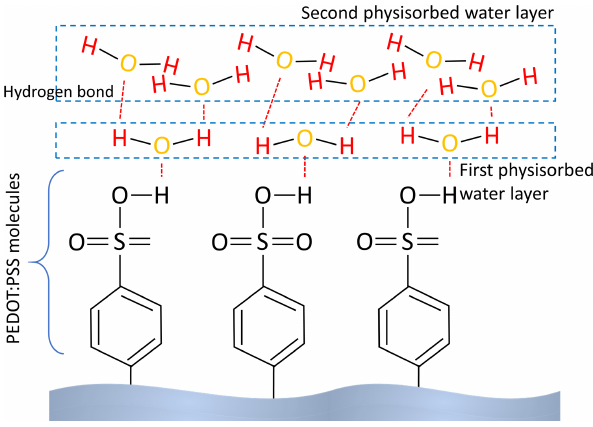
Figure 8. Schematic illustrations of probable interactions between water molecules and PEDOT–PSS sensing